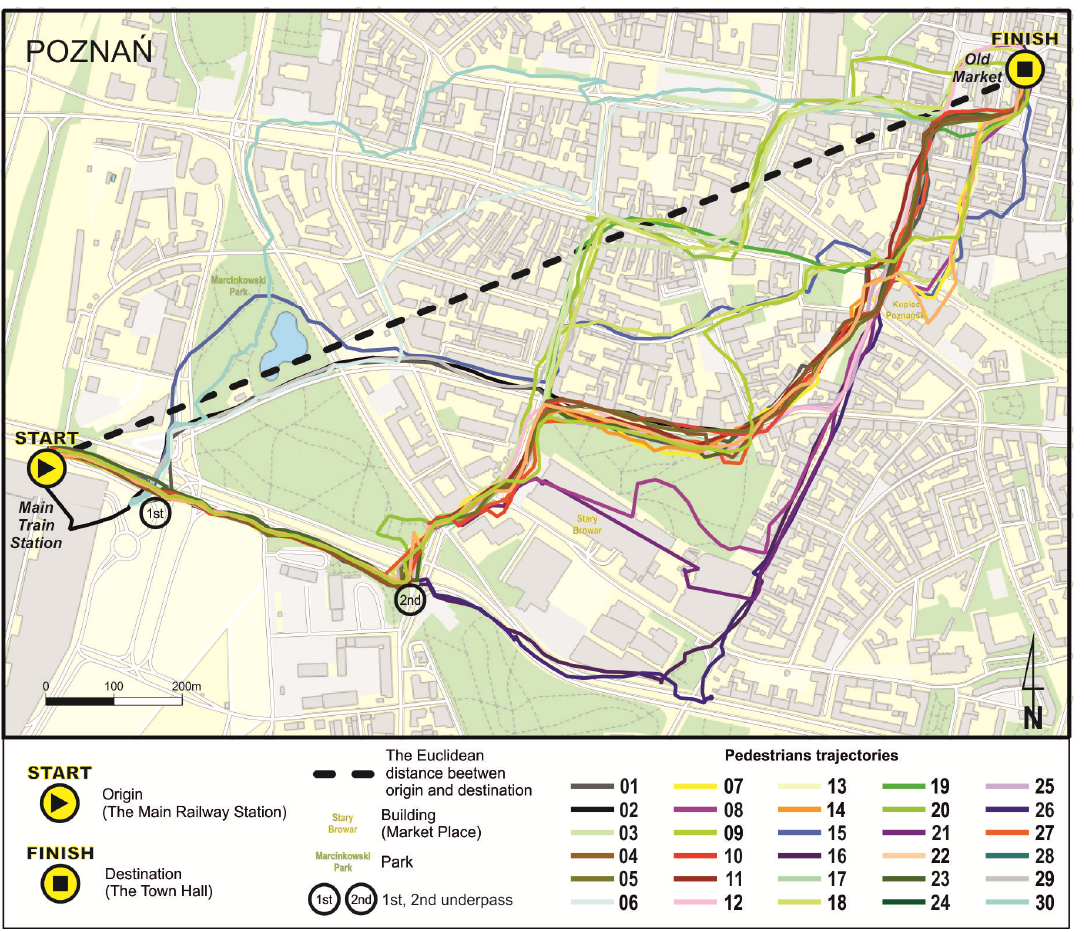
Figure 2. A topographic map with trajectories.